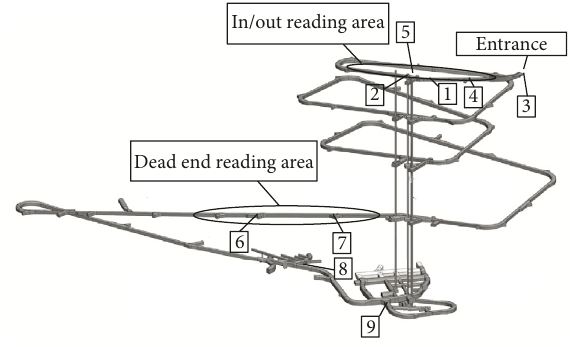
Figure 1: The reading points and reading areas in ONKALO.